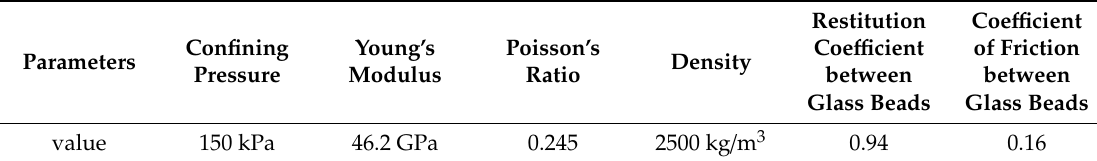
Figure 11. Triaxial test model: ( a ) schematic diagram of triaxial model; ( b ) distribution of particles. Table 6. Parameters of 2 mm glass